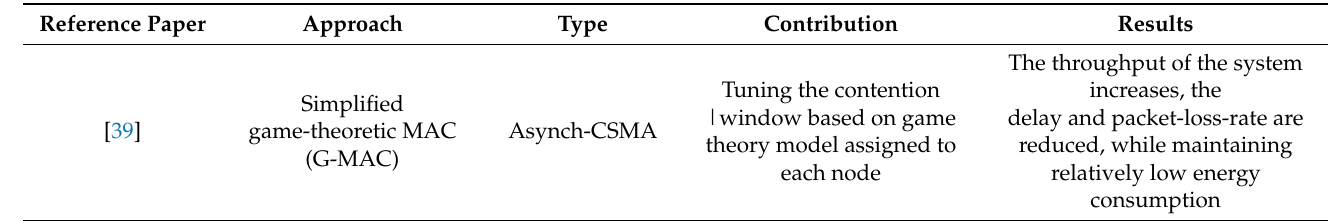
Table 2. Game theory-based MAC